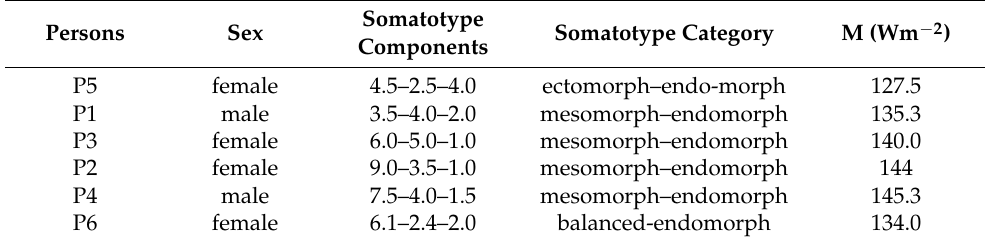
Table 2. The studied person’s somatotype characteristics in the order of metabolic activity